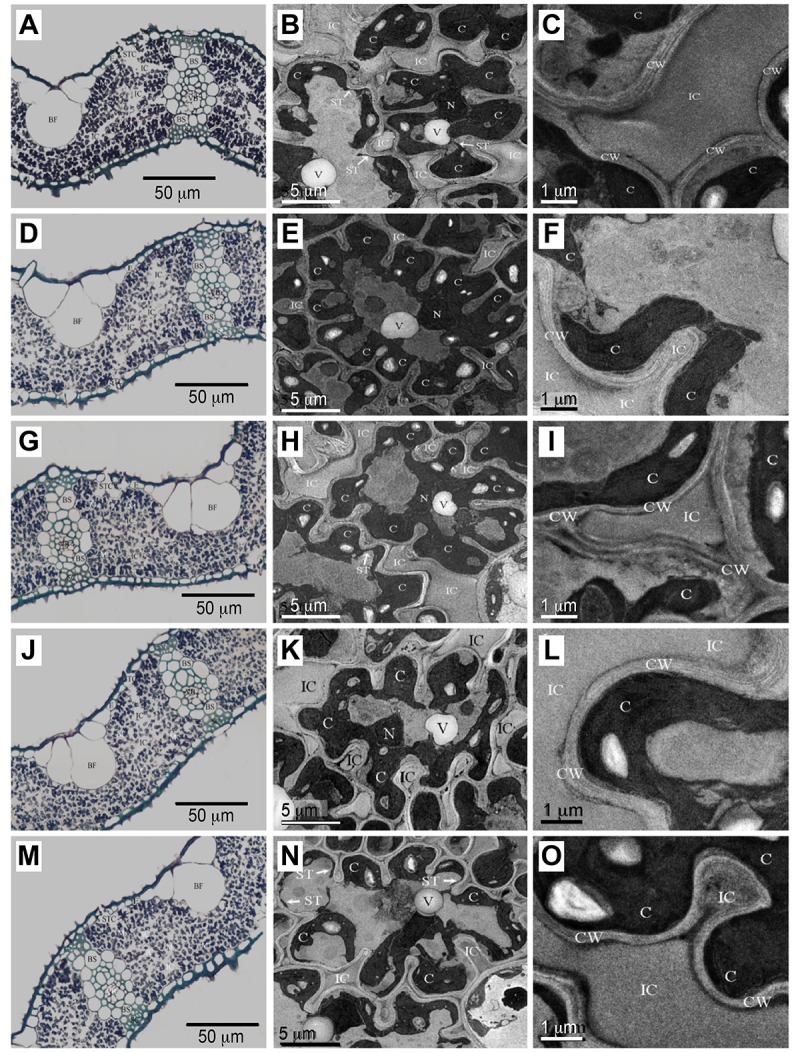
Light and transmission electron micrographs of transverse leaf
sections from empty, transgenic and WT groups.Empty (A, B, C), ICTB (D, E, F), FS (G, H, I), ICTB+FS (J, K, L) and WT
(M, N, O) lines. BF, bulliform cell; BS, outer bundle-sheath cell; C,
chloroplast; CW, mesophyll cell wall; E, epidermis; IC, intercellular
airspace; M, mesophyll cell; N, nucleus; SC, sclerenchyma strand; ST,
stromule, indicated by white arrows; STC, stomatal cavity; V, vacuole;
VB, vascular bundle.